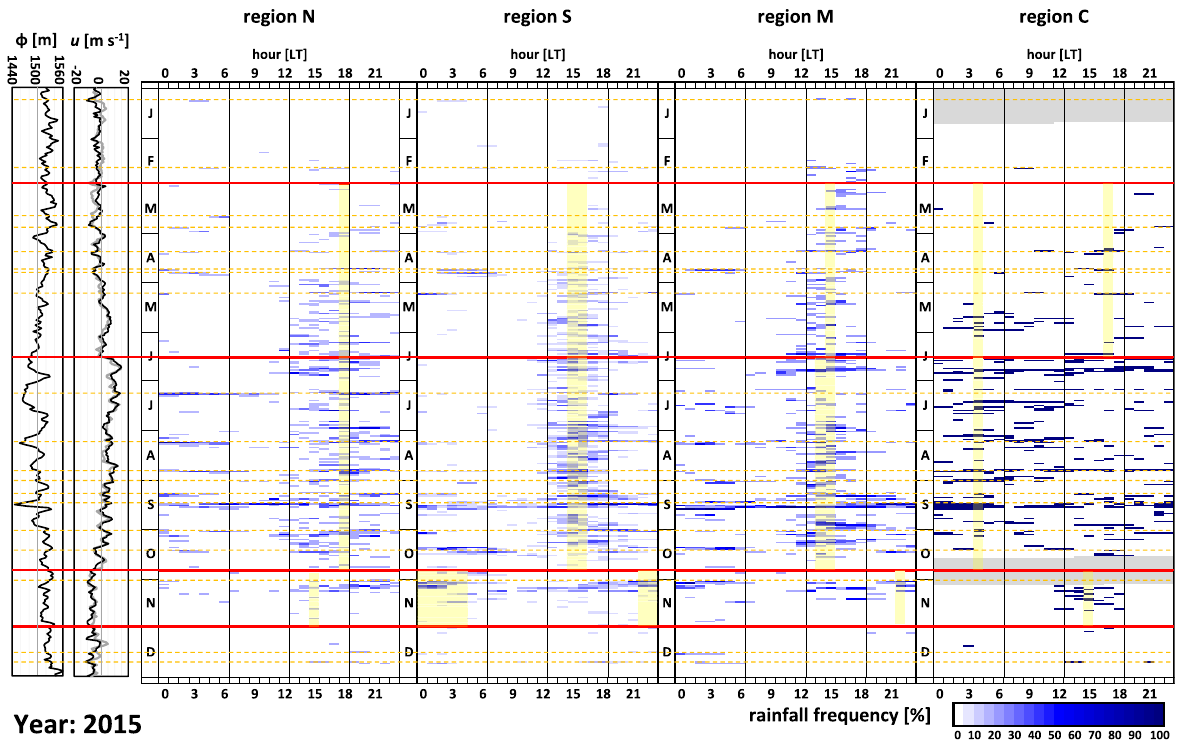
Fig. 8 Same as Fig. 7 but for 2015. Days in the gray-hatched area in region C are “ data-missing days